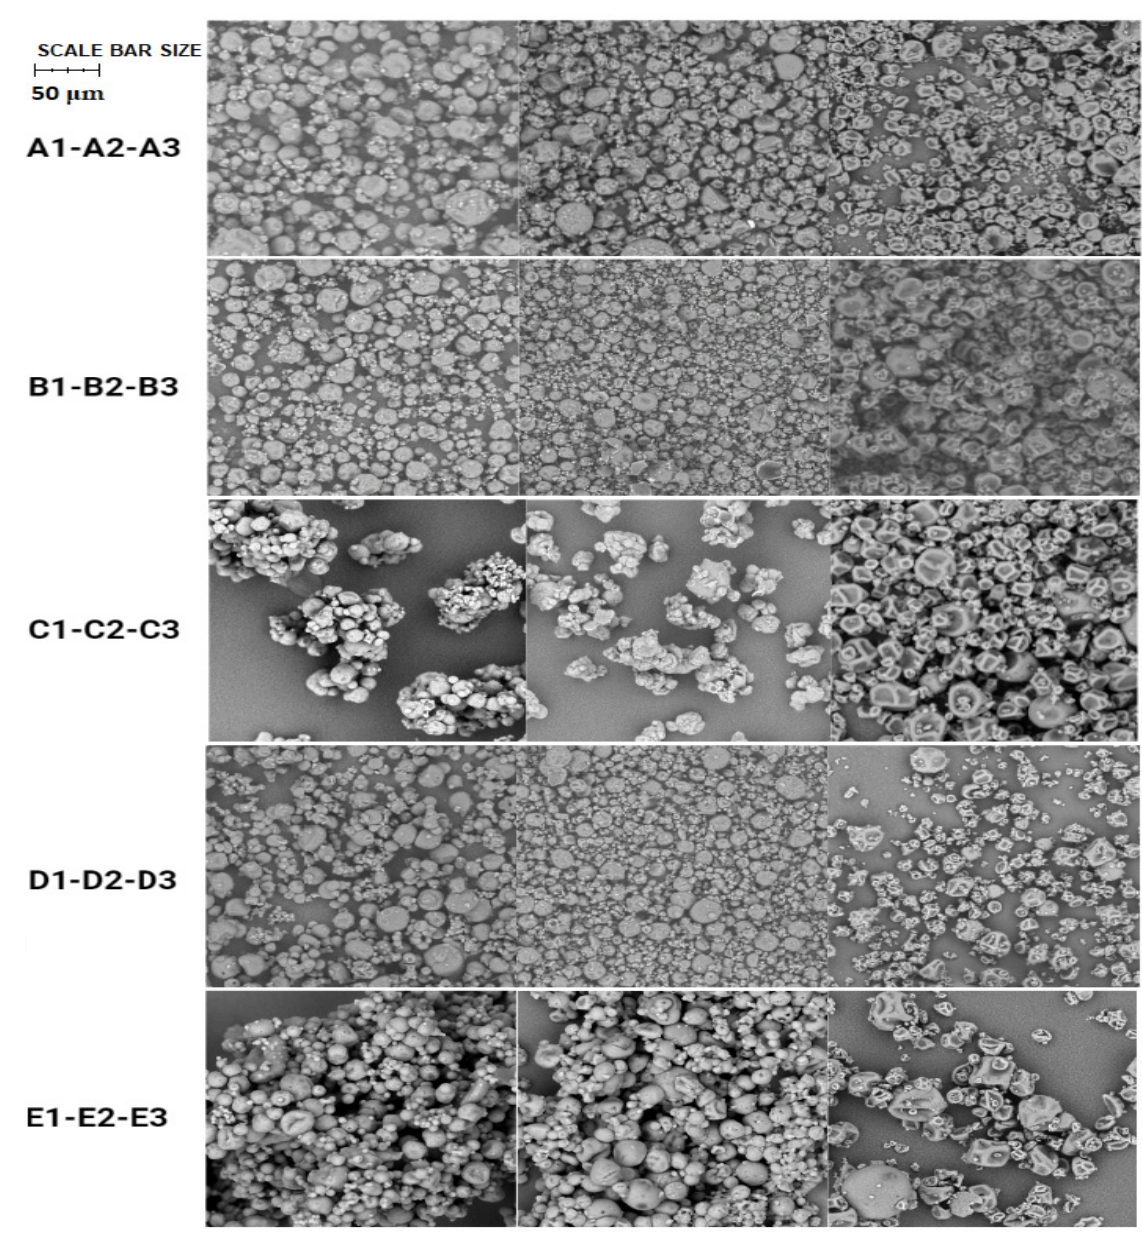
Figure 3. SEM images of the microparticle batches: A1 (retinyl palmitate and Eudraguard Biotic), A2 (retinyl palmitate and CAP), A3 (retinyl palmitate and WPs), B1 ( β -carotene and Eudraguard Biotic), B2 ( β -carotene and CAP), B3 ( β -carotene and WPs), C1 (retinyl acetate and Eudraguard Biotic), C2 (retinyl acetate and CAP), C3 (retinyl acetate and WPs), D1 (cholecalciferol and Eudraguard Biotic), D2 (cholecalciferol and CAP), D3 (cholecalciferol and WPs), E1 ( α -tocopherol and Eudraguard Biotic), E2 ( α -tocopherol and CAP), E3 ( α -tocopherol and WPs). Scale bar size 50 μ m.